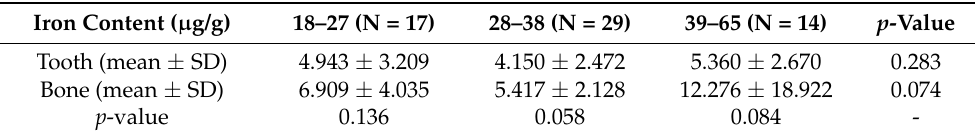
Table 20. Iron content in tested samples taken from patients of different